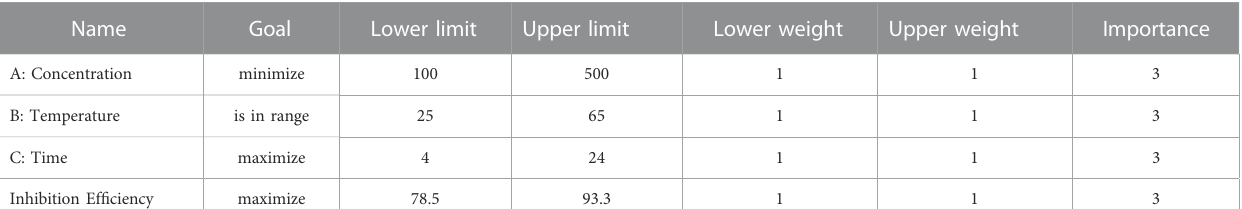
TABLE 5 Optimization constraints.